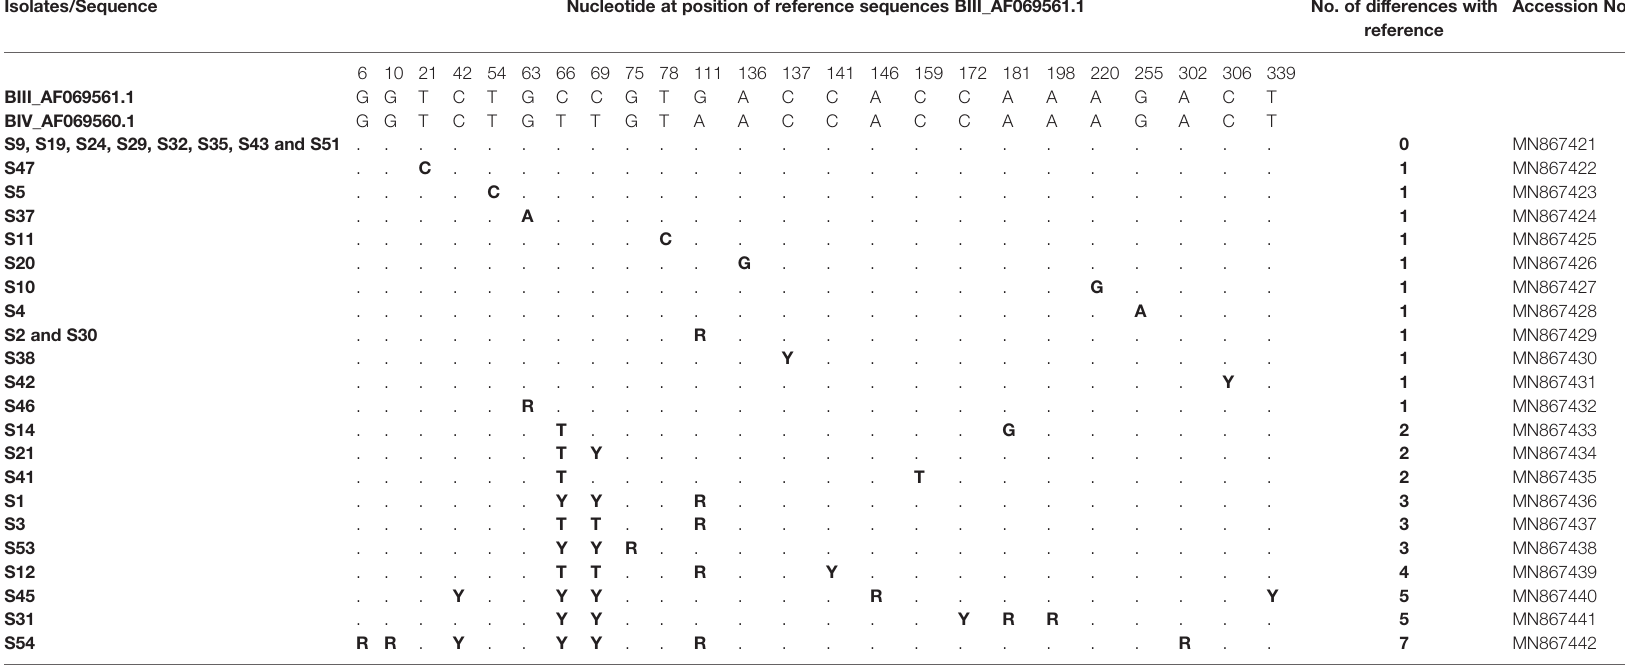
TABLE 7 | Single nucleotide polymorphisms detected within G. duodenalis assemblage B isolates at the tpi locus.